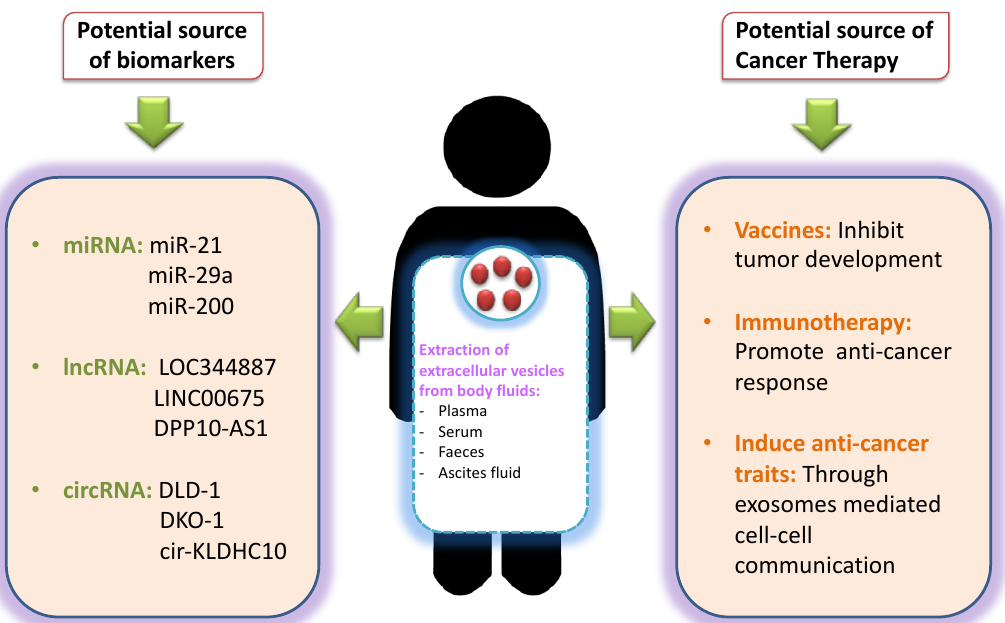
Figure 2. EVs as a potential source of biomarkers and therapeutic targets in CRC: EVs are secreted in various body fluids including plasma, serum, faeces ascites fluid etc. [150]. The detection of cancer associated EVs and its cargoes including miRNA, lncRNA, circ. RNA and several proteins can be used as potential source of biomarkers / prognostic markers in CRC. In cancer therapeutics, engineered EVs can be used for potential vaccine development and induction of immuno-modulatory mechanisms to promote anti-tumor response such as depletion of Tregs and MDSCs, increasing proliferation of NK cells, monitoring of cytokine/chemokines and utilizing EV cargoes as nanoparticles for drug delivery.